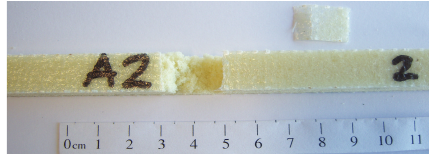
Figure 8: Impact failure observed for composites produced by the autoclave method (A2).